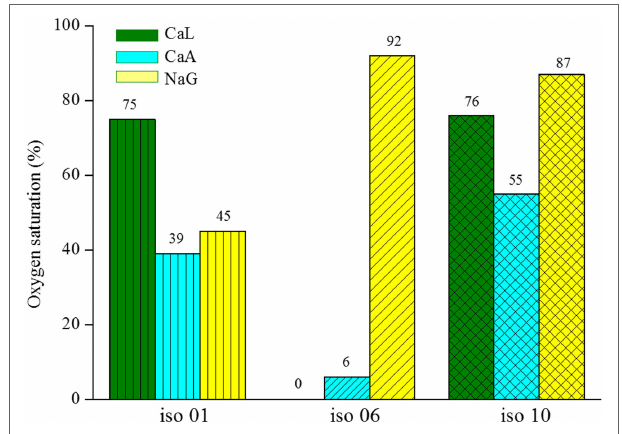
FigUre 4 | Oxygen saturation level of the three different bacteria isolates respiring on calcium lactate (CaL), calcium acetate (CaA), or sodium gluconate